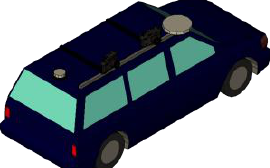
Figure 4. The vehicle equipped with the instruments used during the kinematic